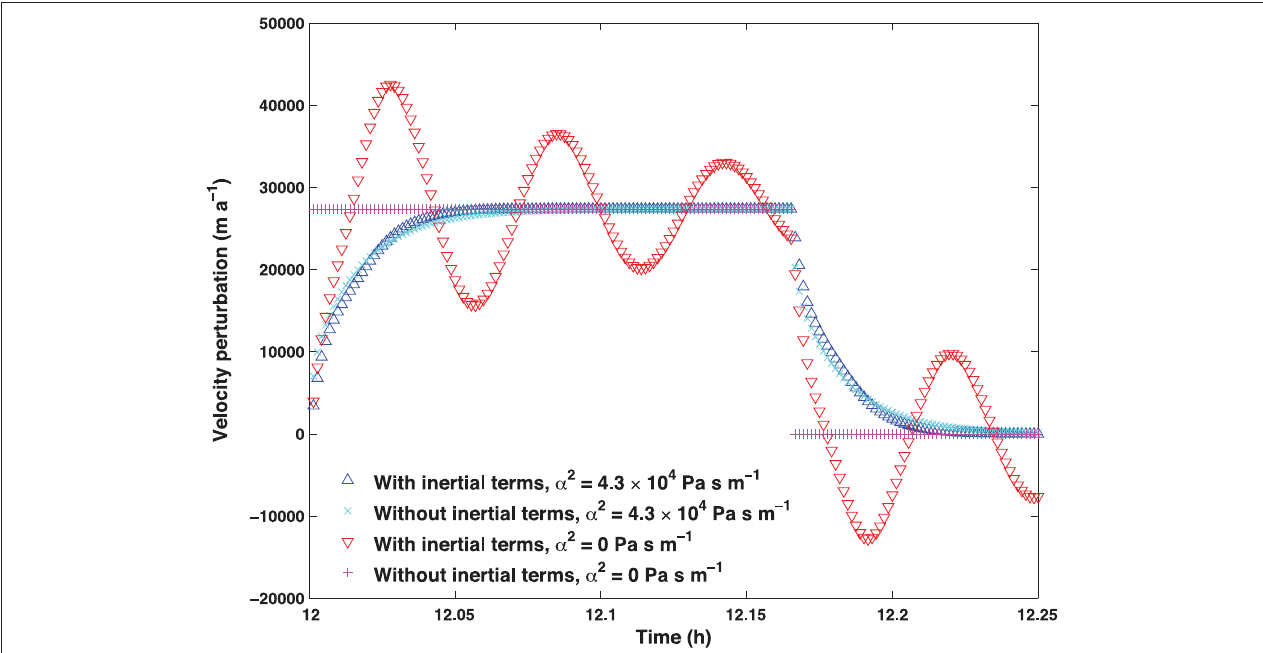
FIGURE 5 | Along-flow velocity perturbation at center of domain (over sticky spot), showing effect of including/excluding inertial terms and/or linearized basal drag.